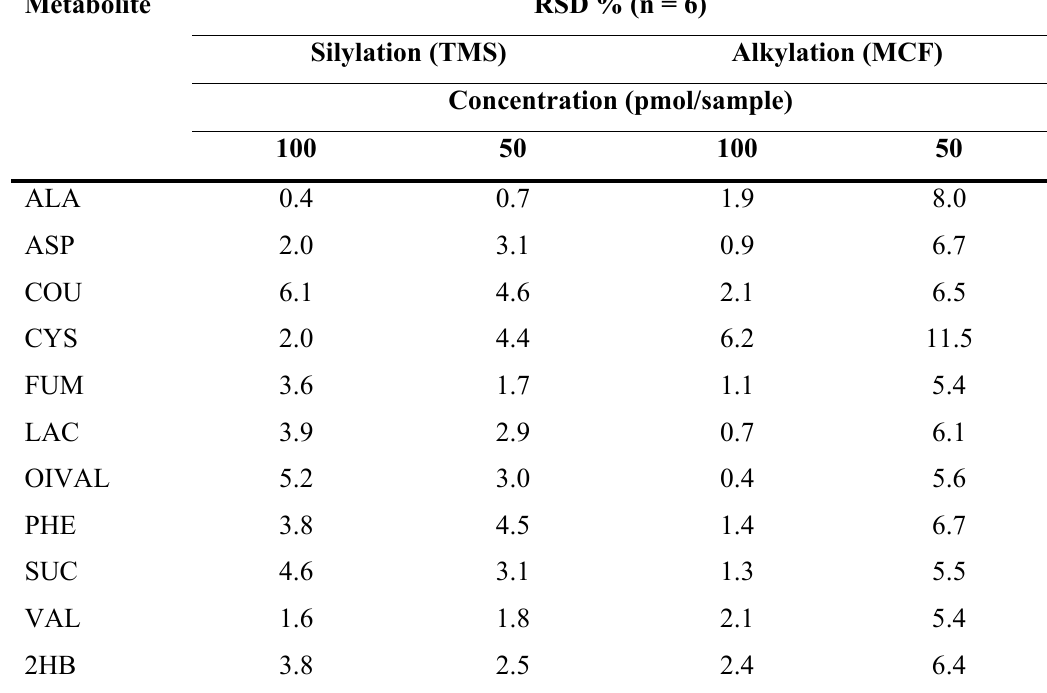
Table 2. Repeatability (RSD) of the GC-MS instrument for some stable metabolite